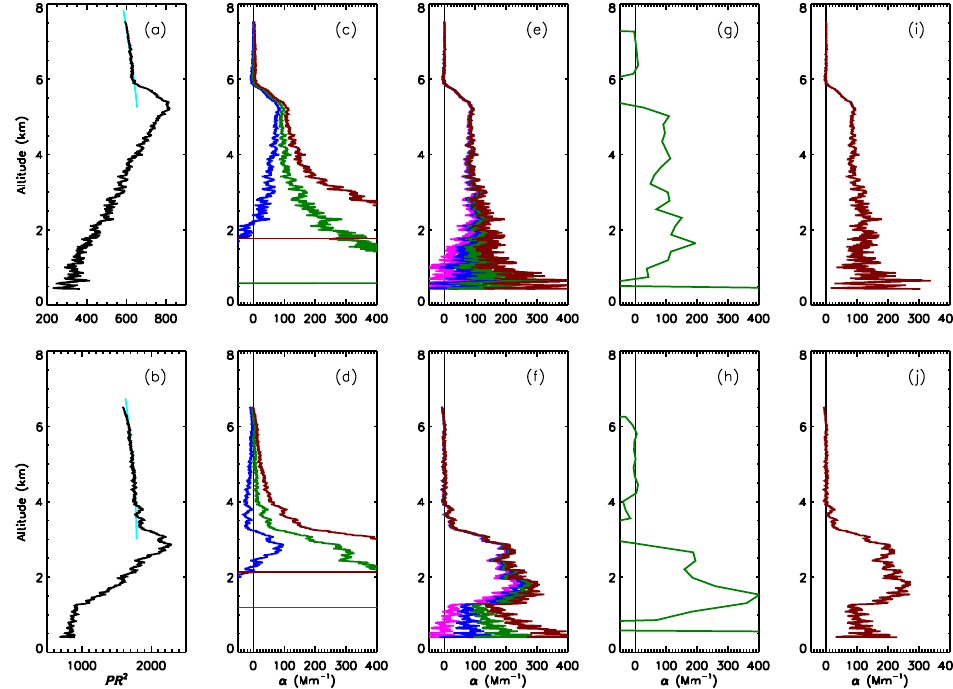
Fig. 1. (a, b) Range corrected signal profiles in arbitrary units for (a) Fennec flight B705, 12/6/2012 at 13:17UTC, integration time 6min (23.9 ◦ N, 5 ◦ W), and (b) SAMBBA flight B741, 26/9/2012 at 15:13UTC, integration time 1min (10.1 ◦ S, 52.6 ◦ W). The cyan line shows the fit to a Rayleigh scattering profile above the aerosols. (c, d) Aerosol extinction coefficient retrieved with the outward Fernald–Klett inversion, assuming a backscatter ratio of 0.98 (blue), 1 (green) and 1.02 (brown) for the molecular layer above the aerosol top. (e, f) Aerosol extinction coefficient retrieved with the inward Fernald–Klett inversion, assuming an average extinction coefficient of 0 (pink), 75 (blue), 150 (green), and 250 (brown) for the 0.5–1km altitude range. (g, h) Aerosol extinction coefficient retrieved with the improved slope method. (i, j) Aerosol extinction coefficient retrieved with the slope-Fernald method.